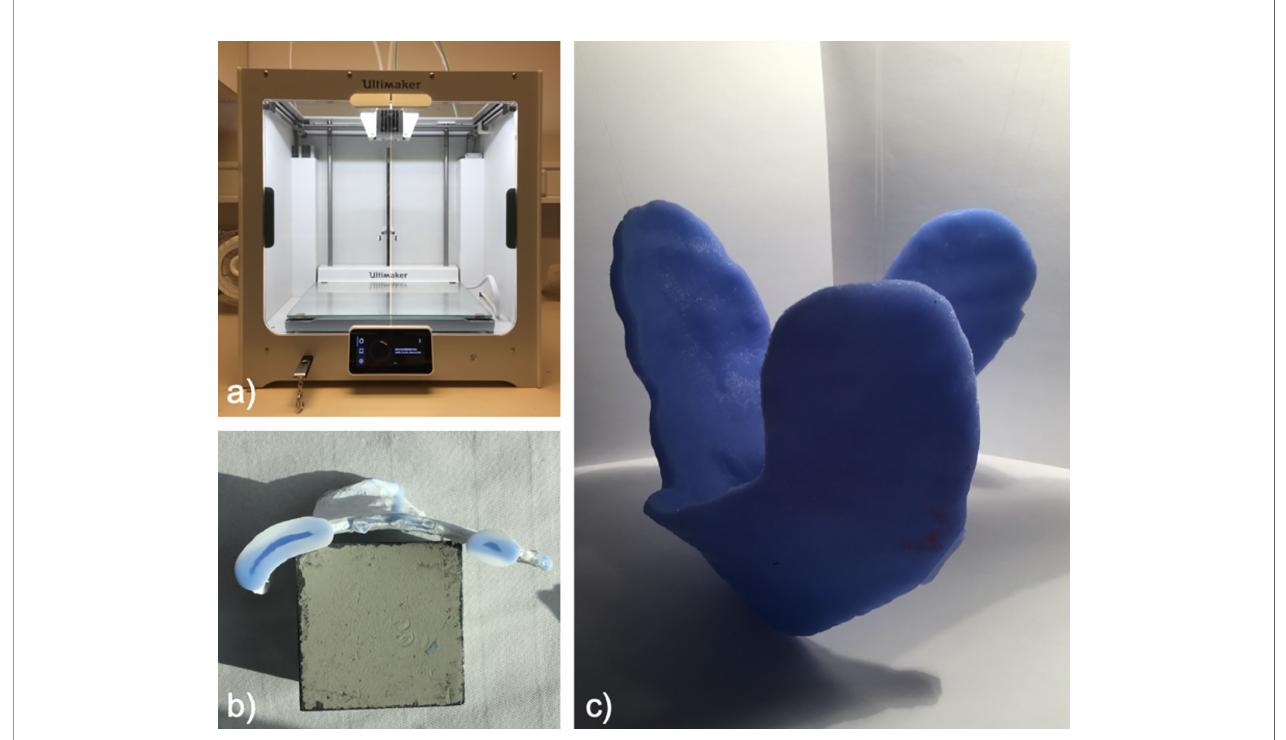
FIGURE 4 | Preparation of the mold with 3D printer (A) , mold (B) , and individual bolus (C)